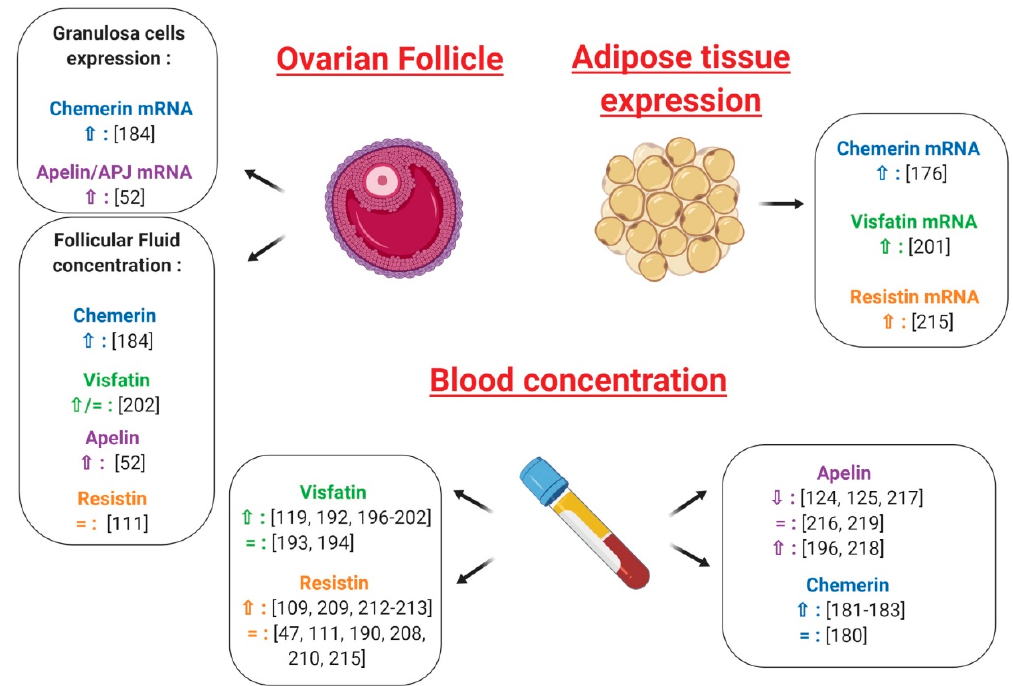
Figure 6. Expression and effects on GnRH (Gonadotropin-Releasing Hormone) release of chemerin, Figure 11. E ff ects of chemerin, visfatin, resistin and apelin on ovarian physiology, plasma and adipose visfatin, resistin and apelin in hypothalamus. ⇧ Increase/stimulation. ⇩ Decrease/inhibition. ND: not tissue in polycystic ovarian syndrome (PCOS) as compared to control patients. ⇧ Increase/stimulation. ⇩ Decrease/inhibition. ND: not visfatin, resistin and apelin in hypothalamus. determined. CSF: cerebrospinal fluid. Decrease / inhibition. determined. CSF: cerebrospinal fluid.